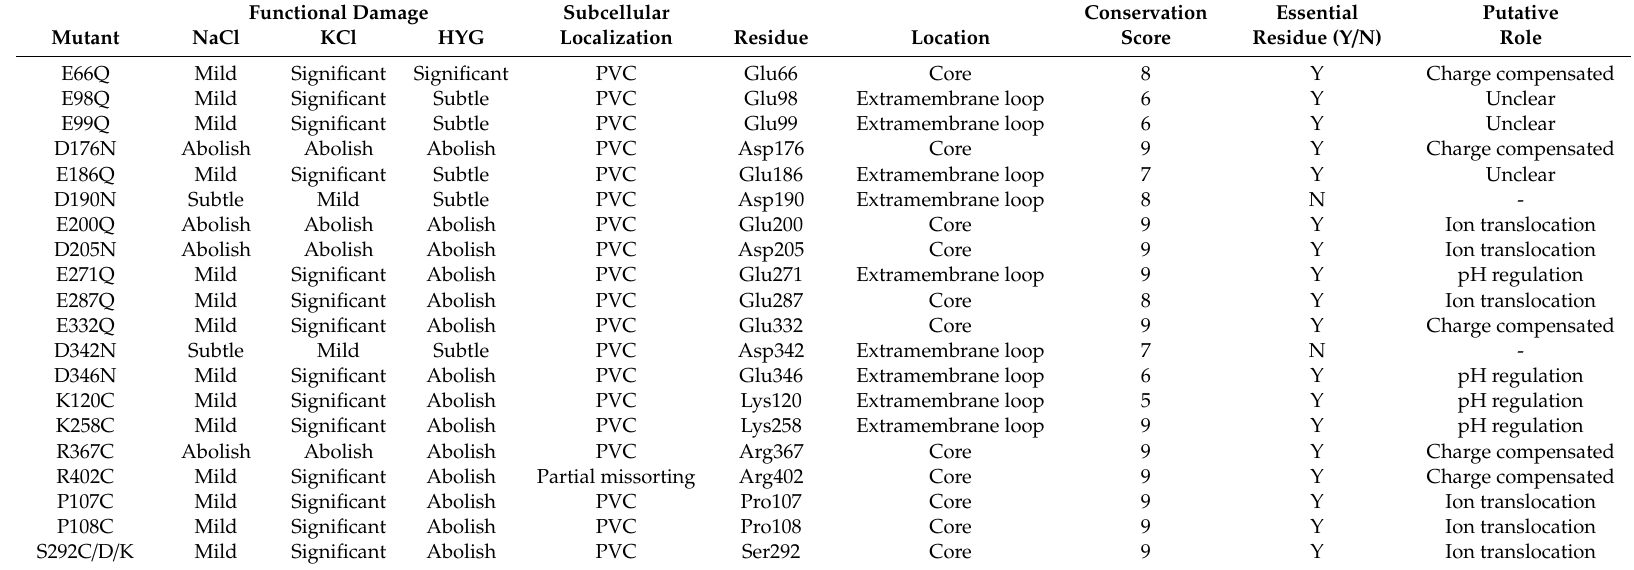
Table 1. Functional evaluation of the point mutants of MnNHX6 in yeast, including functional analysis, subcellular localizations, structural characteristics, evolutionary conservation analysis, and putative